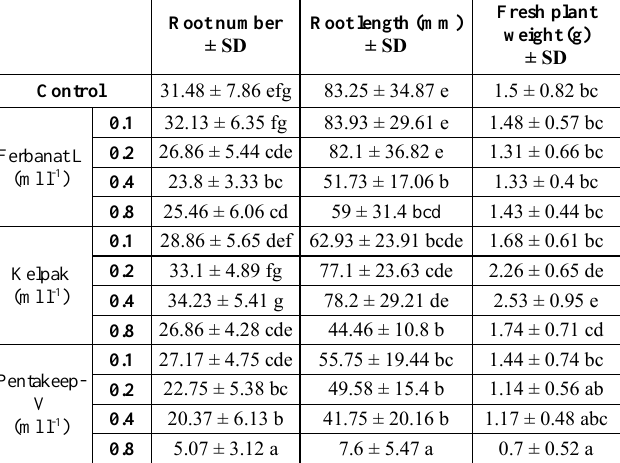
Table 1. Root number and length, fresh weight of in vitro grown Hosta ‘Gold Drop’ plants cultured on Murashige and Skoog (1962) medium with 0.1-0.8 ml L -1 Ferbanat L, Kelpak, Pentakeep-V. Data represented by mean ± standard deviation (SD). Means with different letters are significantly different according to Tukey’s and Games-Howell’s comparison test at